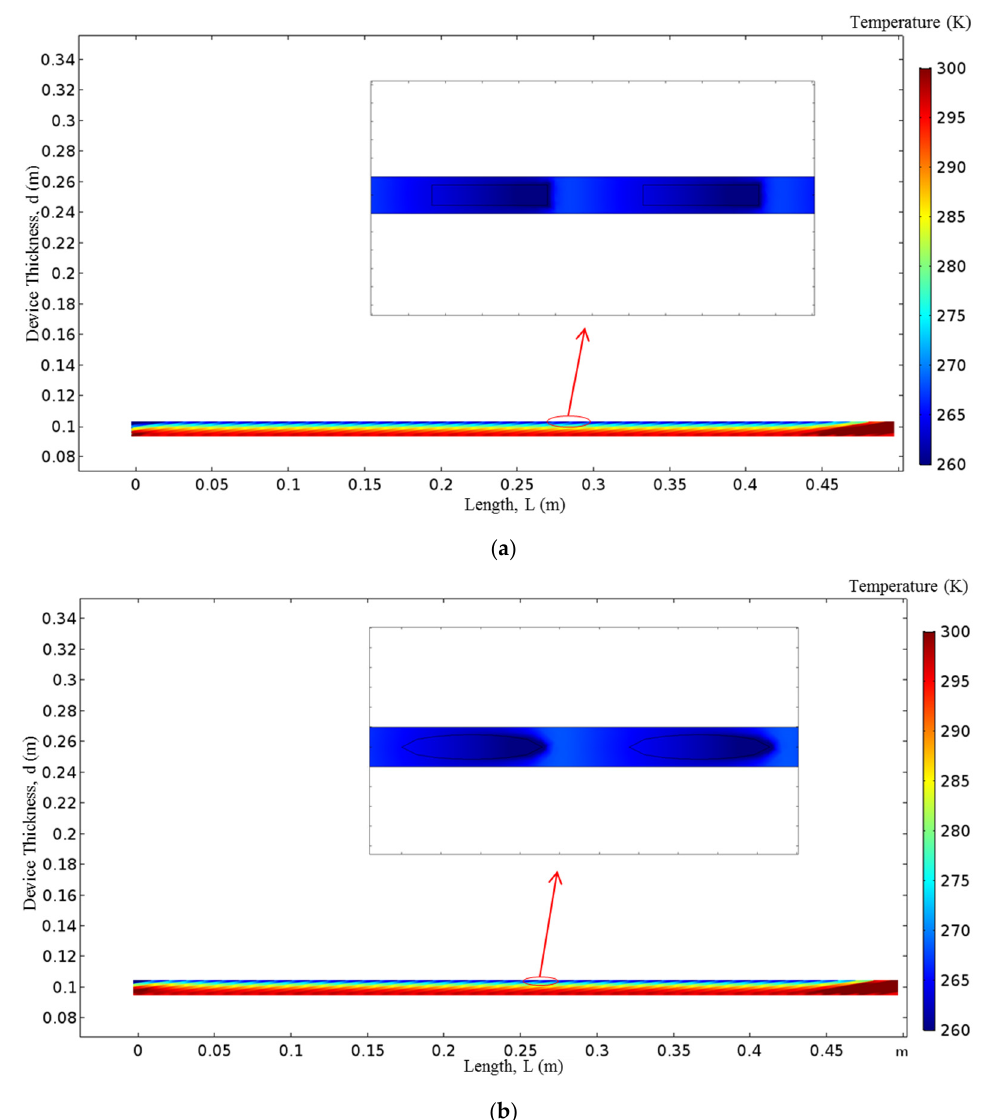
Figure 5. Temperature profiles of transverse fibrous thermoelectric device. ( a ) Square fiber inclusion; ( b ) cylindrical fiber inclusion.